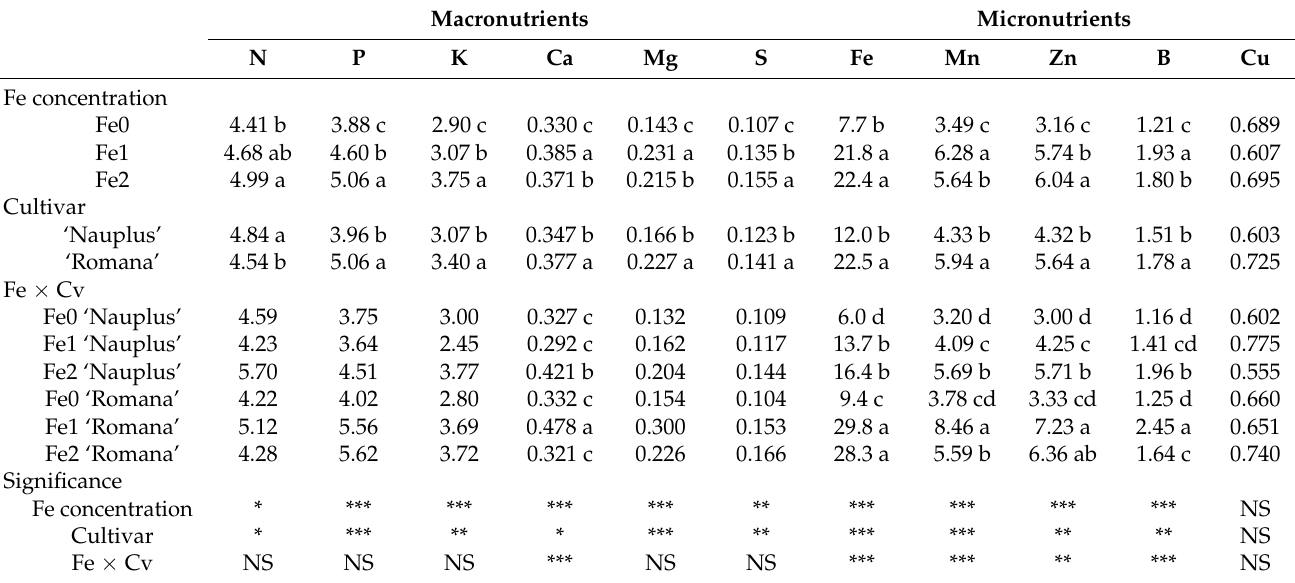
Table 3. Macronutrient (mg g − 1 FW) and micronutrient ( µ g g − 1 FW) composition of lettuce affected by the studied